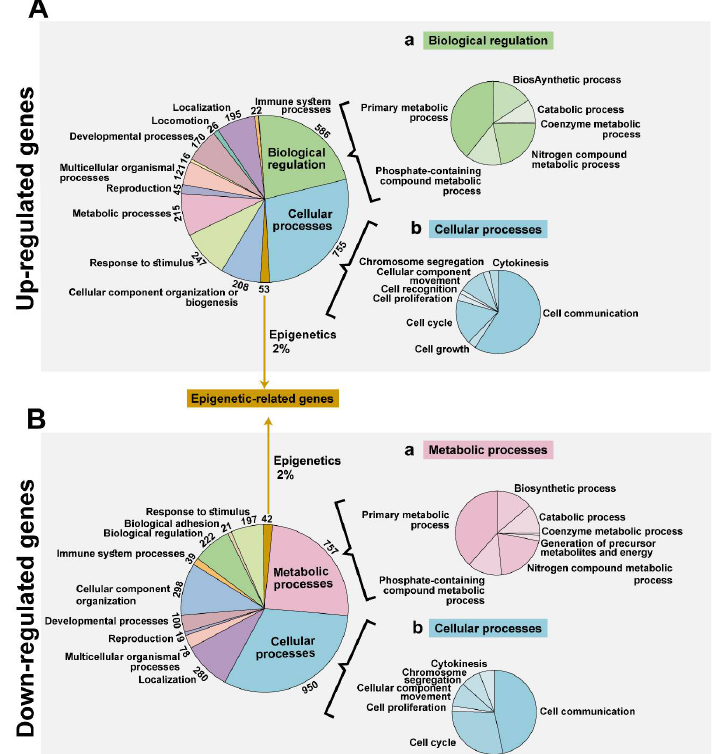
Figure 2. Functional analysis of genes di ff erentially expressed in si-hVDAC1-TTs. RNA, isolated from tumors treated with si-hVDAC1 or si-NT (75 nM), was subjected to A ff ymetrix DNA microarray and bioinformatics analyses. This revealed alterations in about 5271 genes (fold change > 2, FDR-adjusted p -value < 0.05), ofwhich2980geneswereup-regulated( A )and2291weredown-regulated( B ).Functional